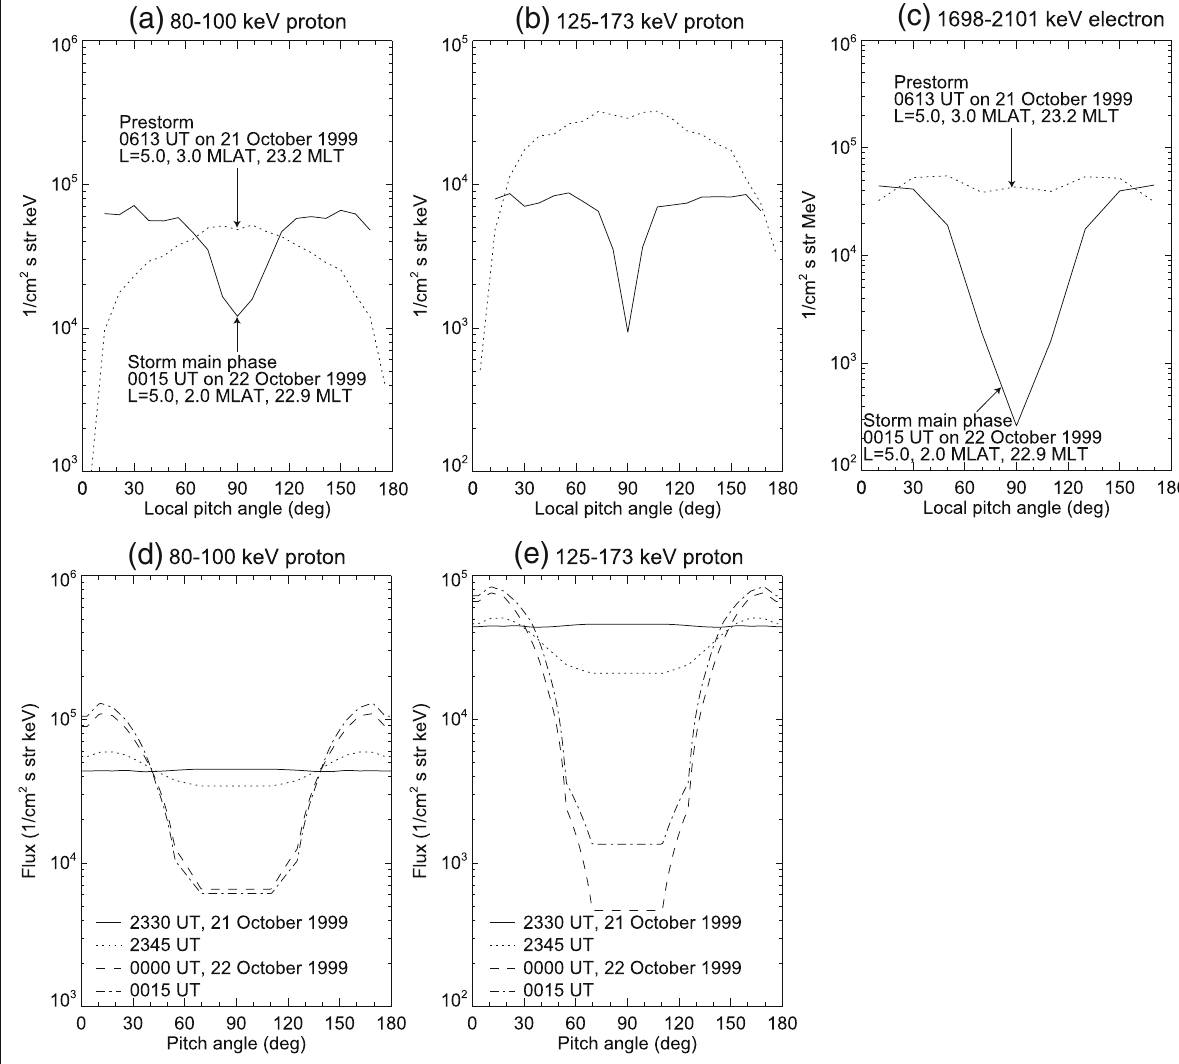
Fig. 7 Example of ring current-radiation belt coupling. Top panels show proton and electron pitch angle distributions observed by the Polar satellite. Bottom panels show proton pitch angle distribution obtained by simulation. (After Ebihara et al. 2008a). a 80 – 100 keV observed proton. b 125 – 173 keV observed proton. c 1698 – 2101 keV observed electron. d 80 – 100 keV simulated proton. e 125 – 173 keV simulated